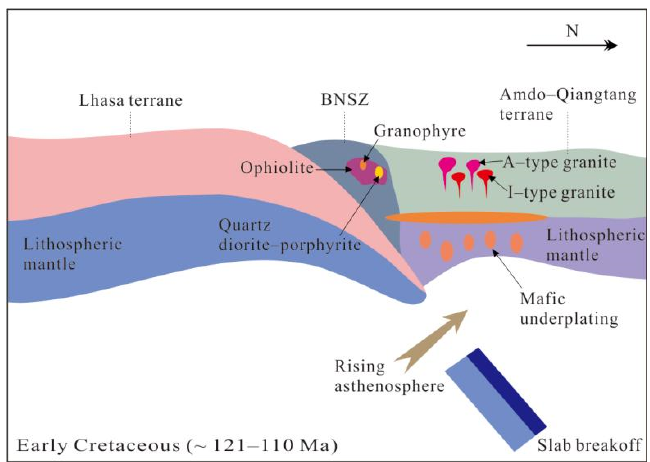
Figure 12. A simplified geodynamic model for the Yilashan and Amdo Early Cretaceous granitoids. Not drawn to scale. The Yilashan and Amdo granitoids were formed related to the Lhasa–Qiangtang collision during the late Early Cretaceous (~121–110 Ma) associated with the northward subducted slab breakoff of the Bangong–Nujiang Tethys Ocean beneath the southern Qiangtang (–Amdo) terrane. The partial melting of the lower crustal source rocks was triggered by asthenospheric upwelling.